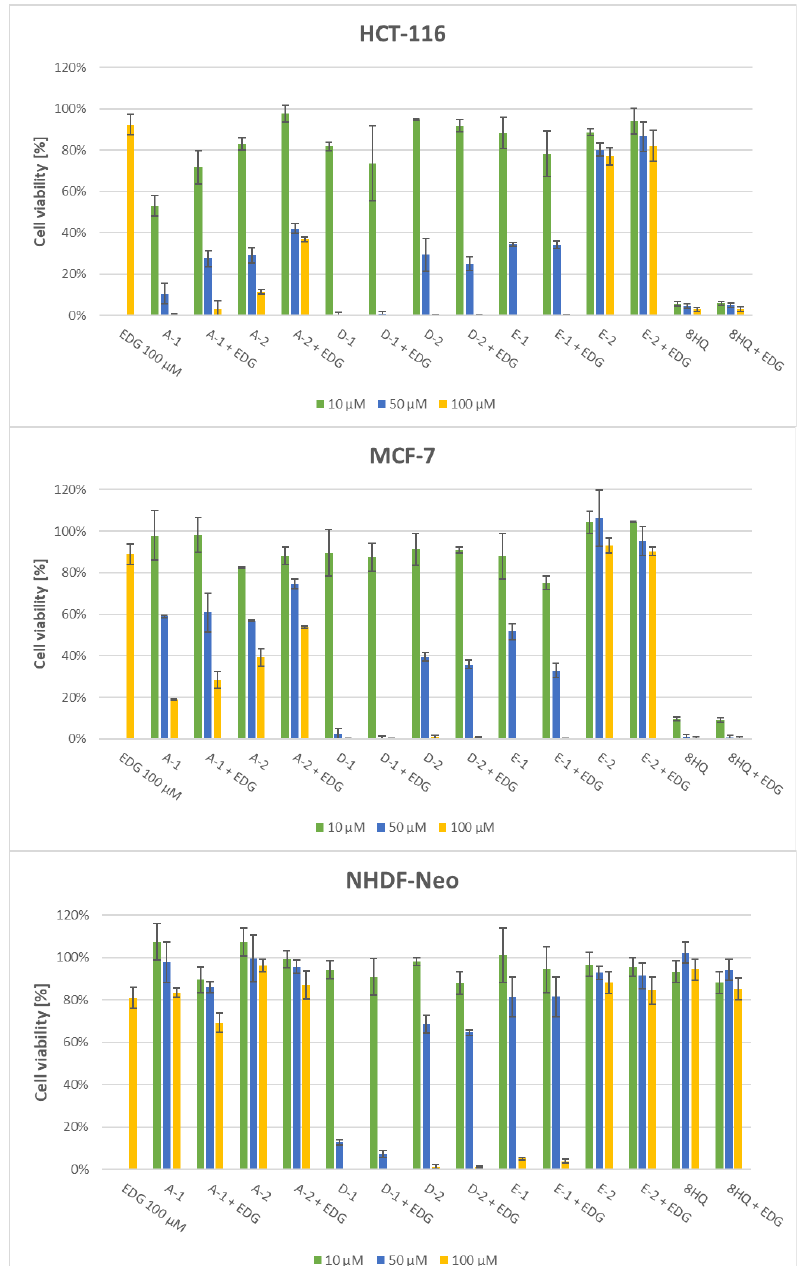
Figure 4. Effect of glucose transporter GLUT1 inhibitor EDG on the activity of compounds A-1 , A- 2 , D-1 , D-2 , E-1 , E-2 , and 8HQ for 72 h incubation with HCT-116, MCF-7, and NHDF-Neo cells. Cell viability was measured by the MTT test. Data are presented as the mean ± standard deviation ( n = 2).